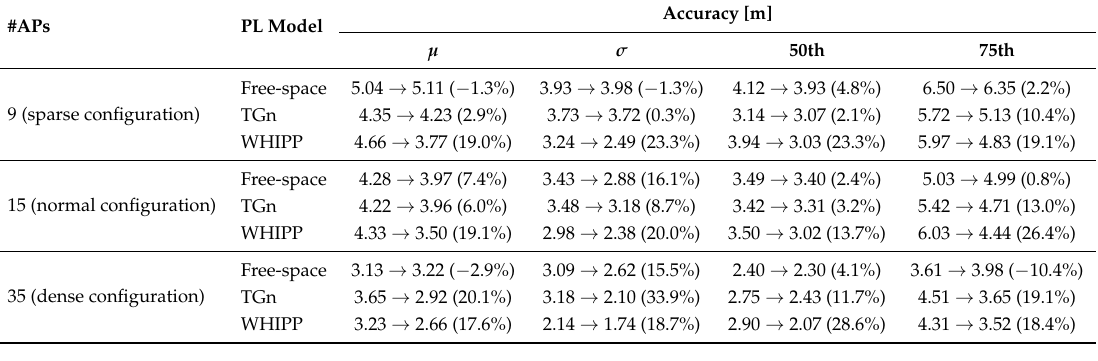
Table 2. Accuracy of experimental validation test set per access point (AP) configuration and path loss (PL) model. The first and second value are the accuracy before and after training and the third value is the relative improvement.